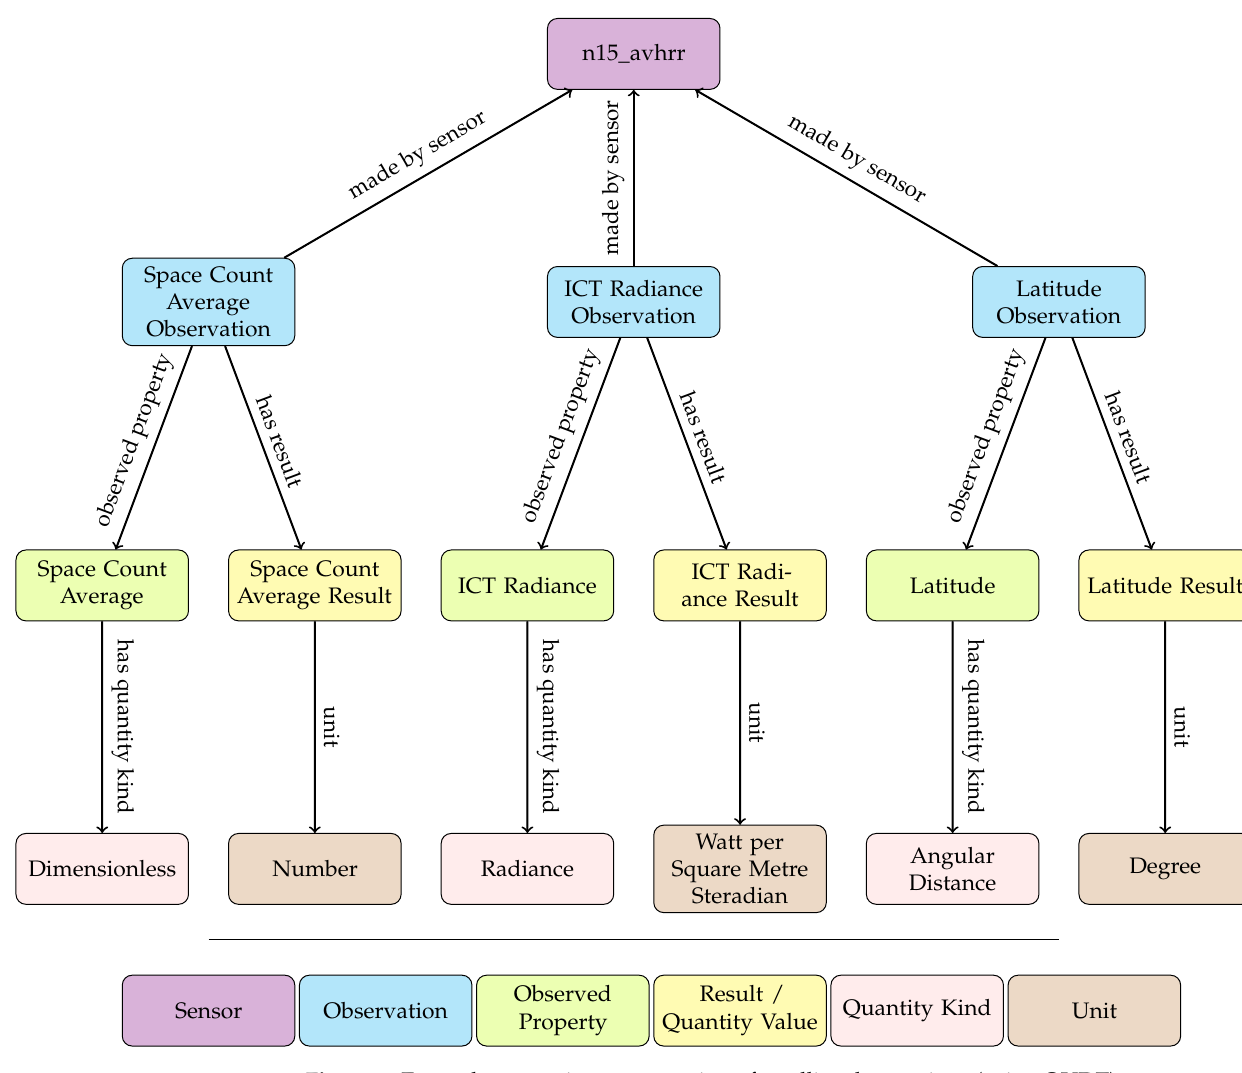
Figure 5. Example semantic representation of satellite observations (using